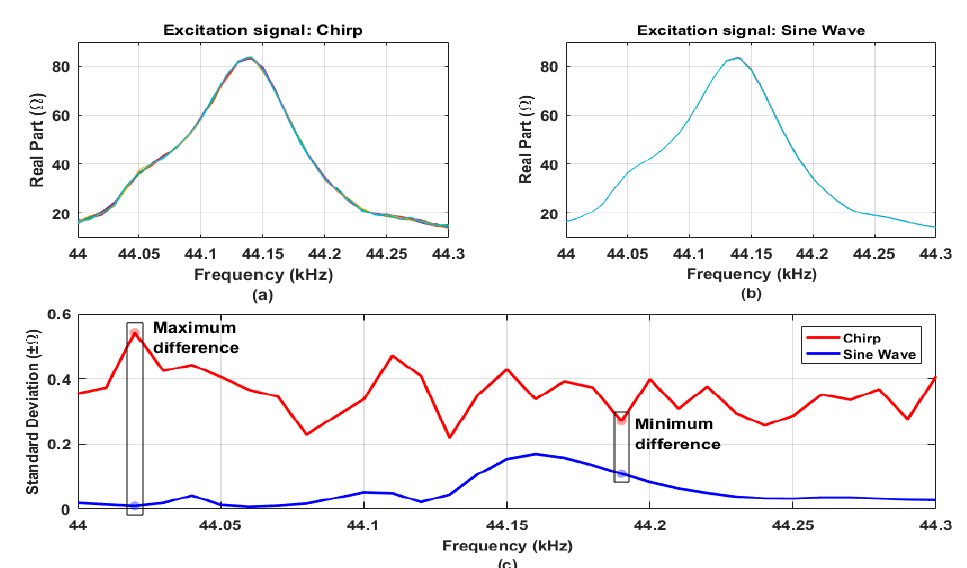
Figure 2. Twenty measurements performed using ( a ) chirp signal and ( b ) sine waves, and ( c ) their respective point-to-point standard deviations.